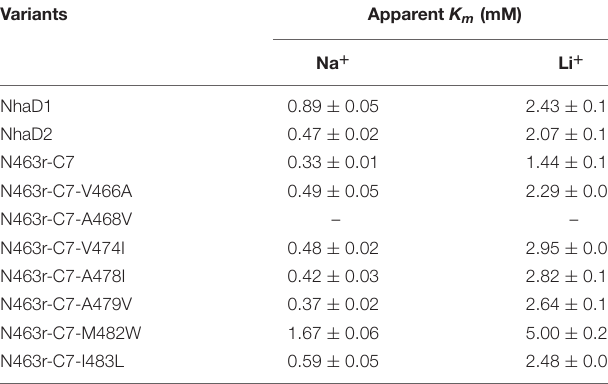
TABLE 3 | Apparent K m values of constructed fusion proteins in TM